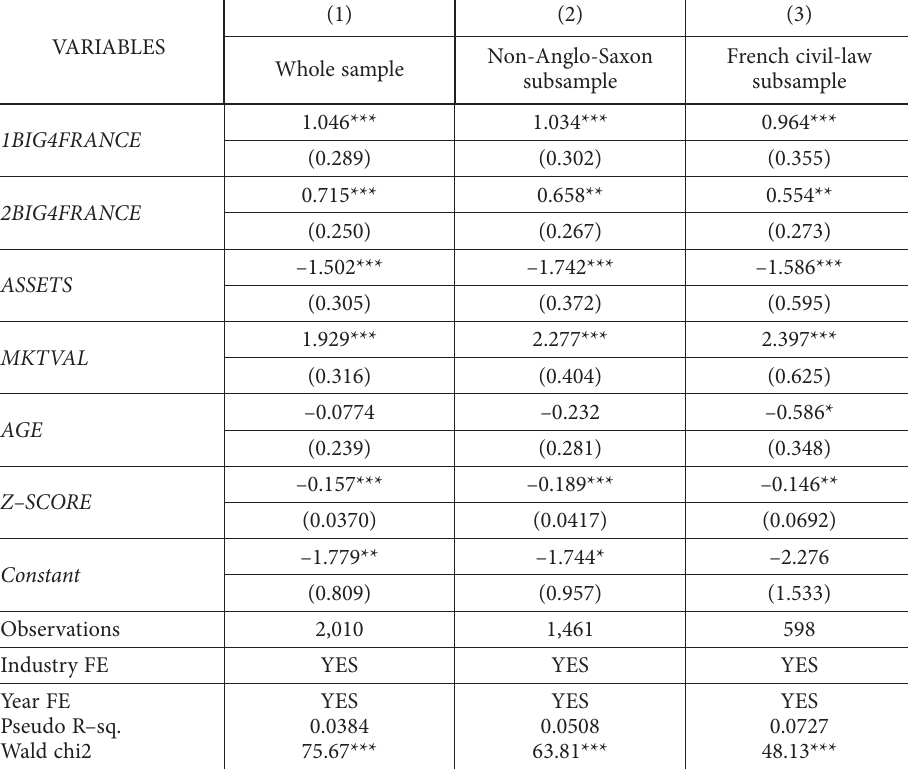
Table 7. Joint audits and the likelihood of just beating earnings benchmarks by audit firm